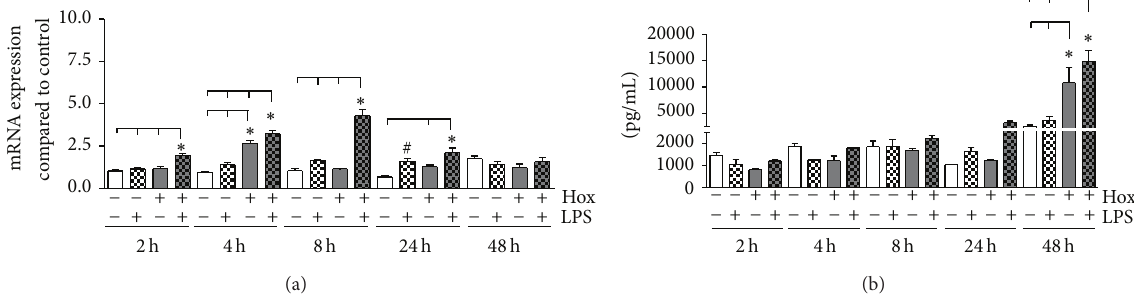
Figure 2: Expression of MMP-1 in PDL cells . (a) PDL cells were cultured under normoxic or hypoxic condition and stimulated with LPS-PG (1 𝜇 g/mL). Untreated cells cultured in normoxia served as control. MMP-1 mRNA expression was quantitated by real-time PCR after 2, 4, 8, 24, and 48 h. Statistical differences were analyzed by one-way ANOVA followed by different post hoc tests (Dunnett’s and Tukey’s multiple comparison test); a 𝑃 value < 0.05 was assumed as significant. # 𝑃 < 0.05 depicts a significant difference with respect to the time-matched control, ∗ 𝑃 < 0.05 indicates a significant difference between groups (means ± SD; 𝑛 = 9 ). (b) MMP-1 protein secretion by PDL fibroblasts was determined using the Quantikine enzyme-linked immunoabsorbent assay (ELISA) system according to the manufacturer’s instruction. Supernatants of PDL cells stimulated with or without LPS-PG (1 𝜇 g/mL) under normoxic or hypoxic condition were collected after varying time points (2, 4, 8, 24, and 48 h). Statistical differences were analyzed by one-way ANOVA followed by different post hoc tests (Dunnett’s and Tukey’s multiple comparison test); a 𝑃 value < 0.05 was assumed as significant. ∗ 𝑃 < 0.05 indicates a significant difference between groups (means ± SD; 𝑛 = 9